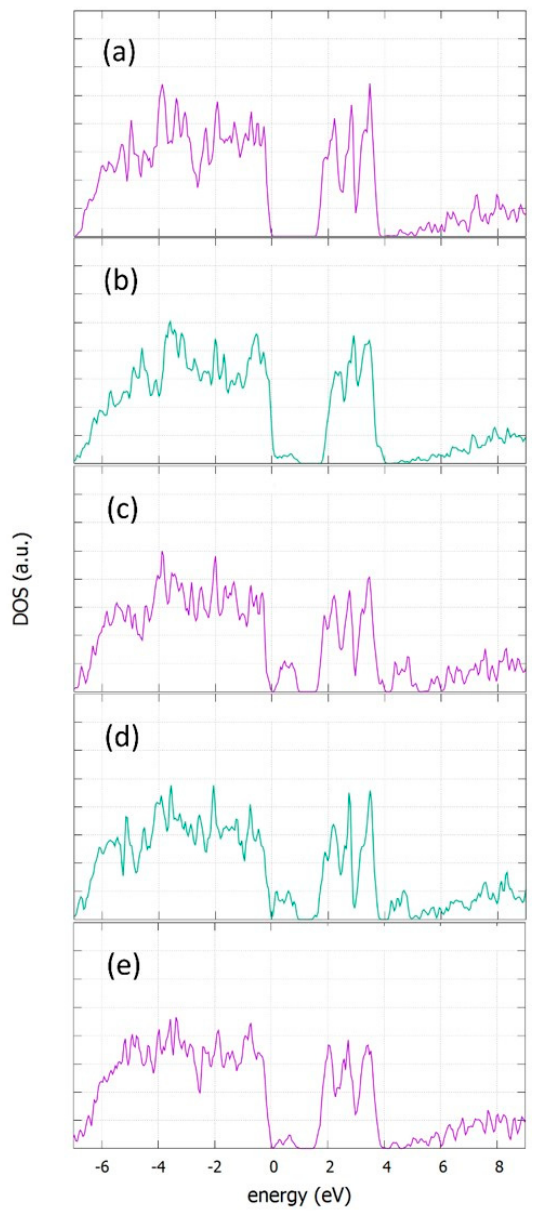
Figure 9. Density of states of ( a ) perfect, ( b ) Co Fe - ( c ) Ge Fe - ( d ) Si Fe - and ( e ) Zn Fe -doped α -NaFeO 2 .